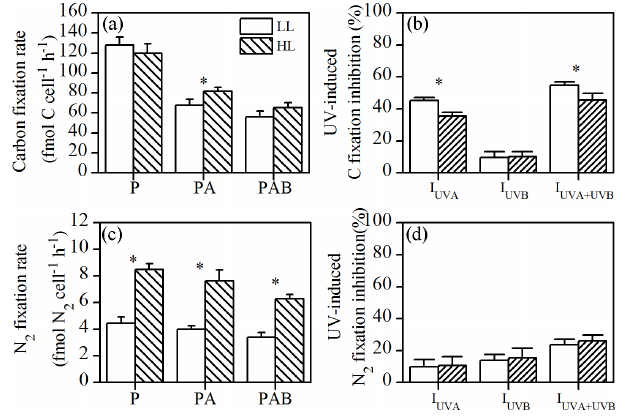
/F (cid:48) Figure 1. Changes of effective quantum yield ( F (cid:48) ) of Tri- V M Figure 2. Photosynthetic carbon fixation rate ( a ; chodesmium IMS101 grown under (a) LL and (b) HL con- fmolCcell − 1 h − 1 ) and UV-induced C fixation inhibition (b) , ditions while exposed to PAR (P), PAR + UVA (PA), and N 2 fixation rate ( c ; fmolN 2 cell − 1 h − 1 ) , and corresponding PAR + UVA + UVB (PAB) under a solar simulator for 60min. PSII UV-induced N 2 fixation inhibition (d) of Trichodesmium IMS101 damage ( c ; k , in min − 1 ) and repair rates ( d ; r , in min − 1 ) of LL- grown under LL and HL conditions. Asterisks above the histogram and HL-grown cells were derived from the yield decline curve in bars indicate significant differences between LL- and HL-grown the upper panels. Asterisks above the histogram bars indicate sig- cells. Values are the mean ± SD for triplicate nificant differences between LL- and HL-grown cells. Values are the mean ± SD for triplicate incubations.